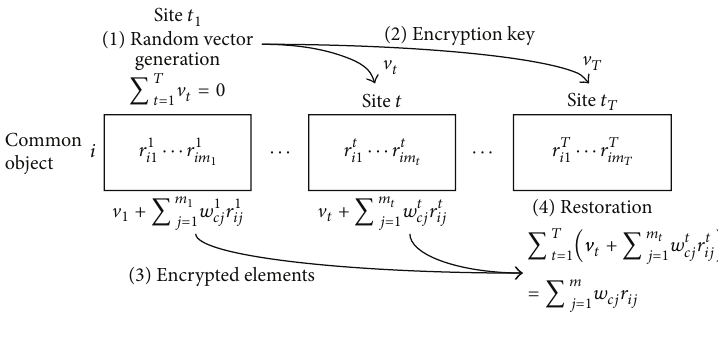
Figure 2: Calculation of ∑ 𝑚 𝑗=1 𝑤 𝑐𝑗 𝑟 𝑖𝑗 with encryption